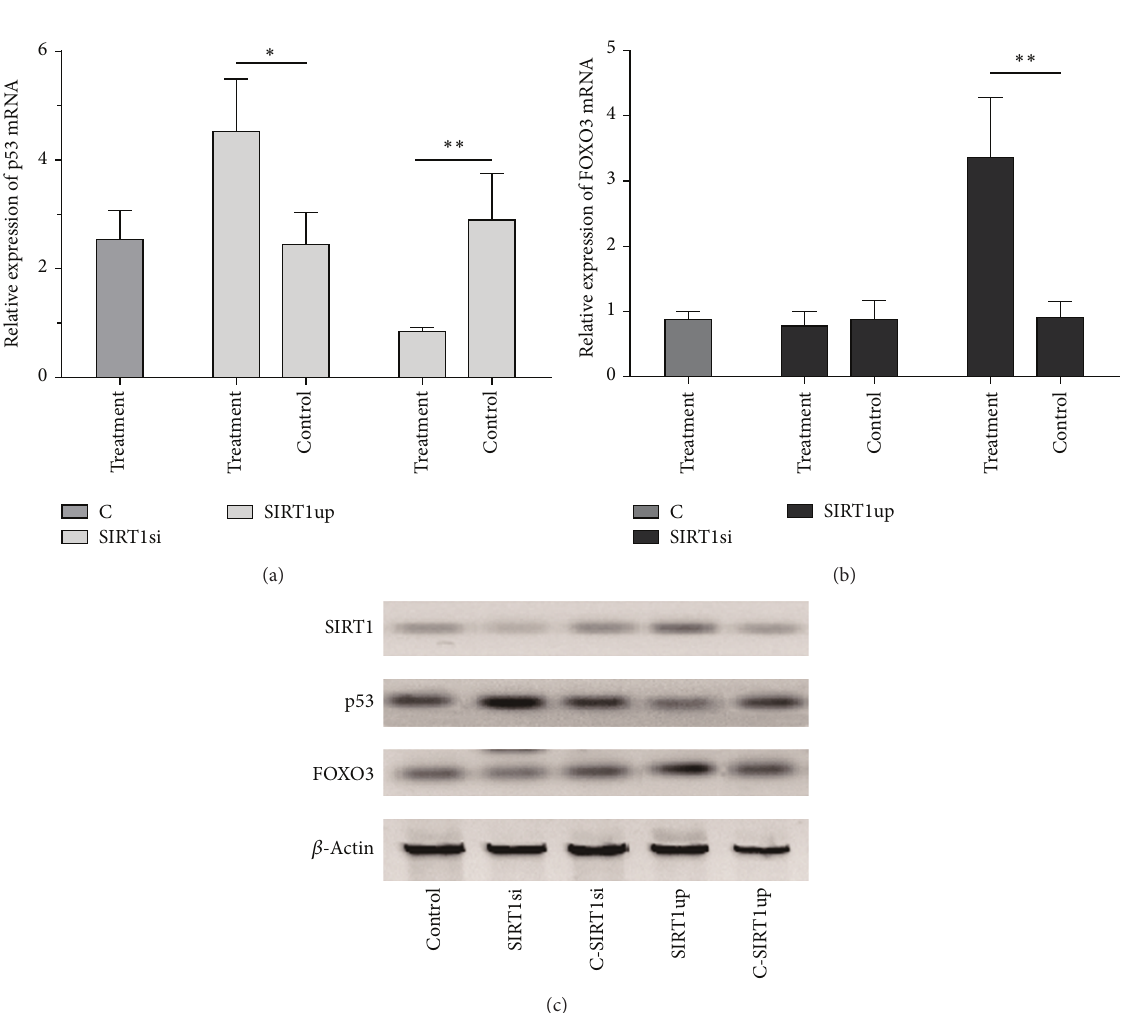
Figure4:RegulationofFoxO3andp53wasinvolvedintheexpressionofSIRT1ratherthanVitC.ARPE-19cellsunderwentSIRT1knockdown and overexpression of SIRT1 by using siRNA (SIRT1si group), pRC/CMV-SRIT1 (SIRT1up group), and its control (C-SIRT1si and